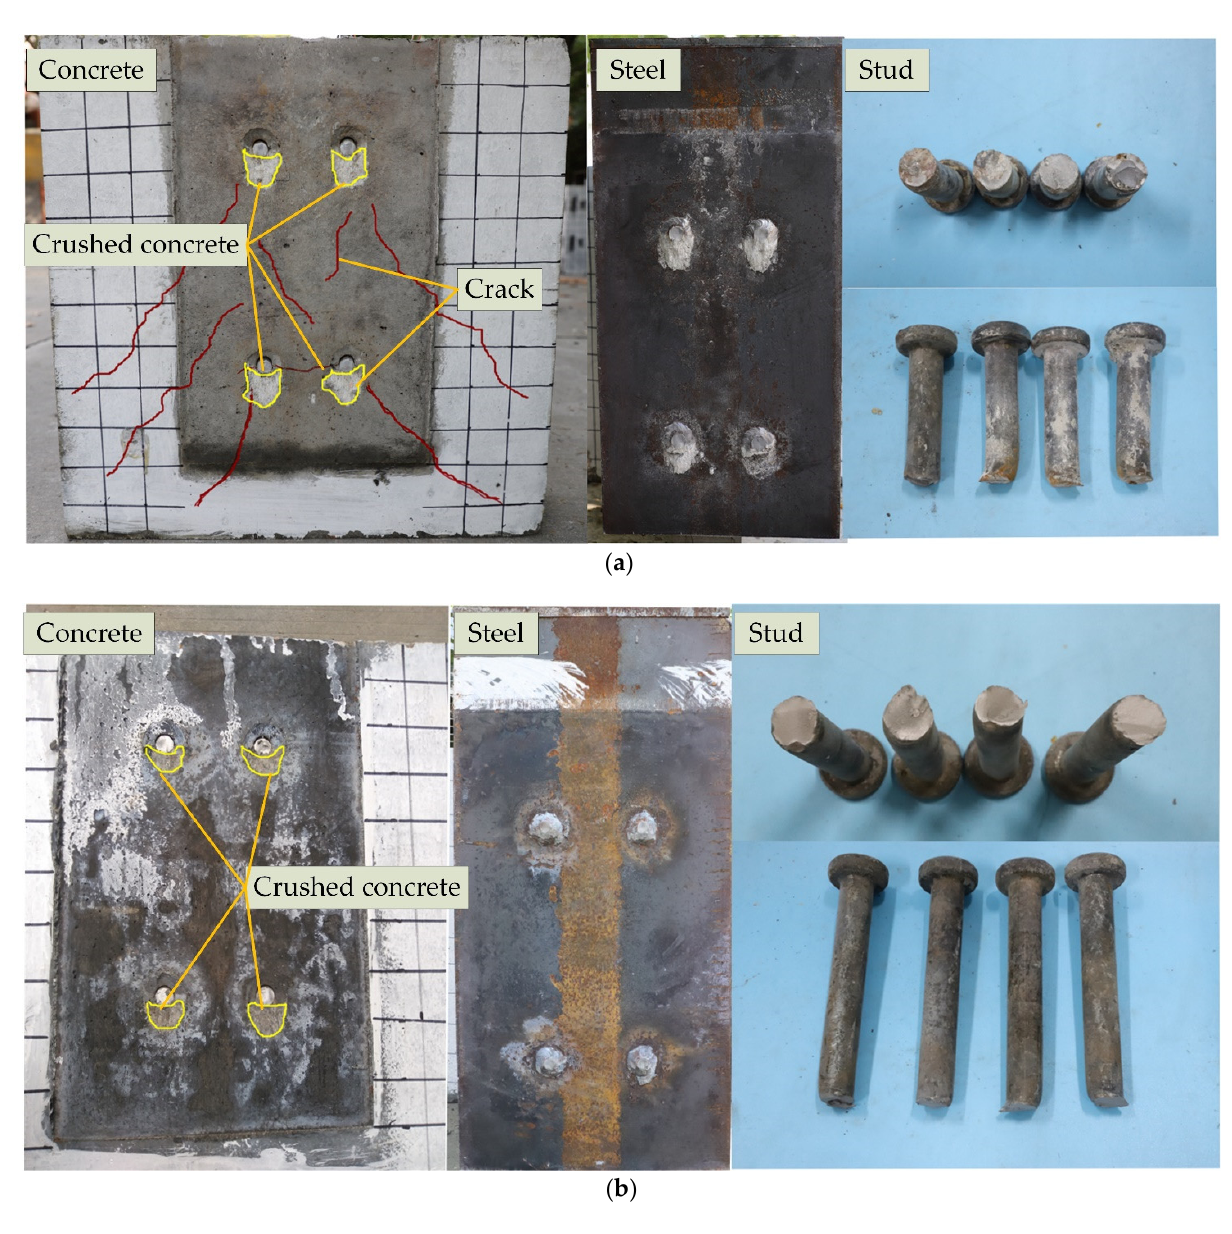
Figure 5. Failure modes of different test specimens: ( a ) N-80-18; ( b ) S-80-18.